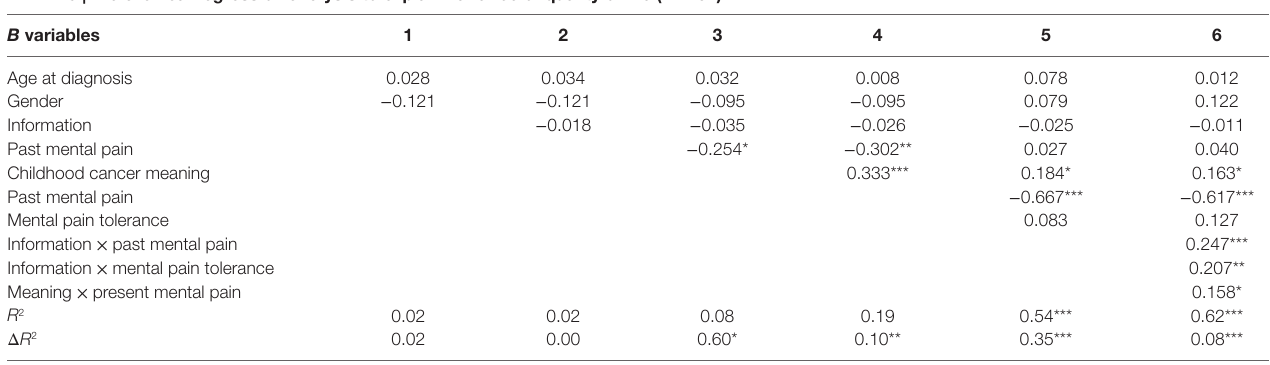
TaBle 5 | hierarchical regression analysis to explain variance of quality of life ( N =